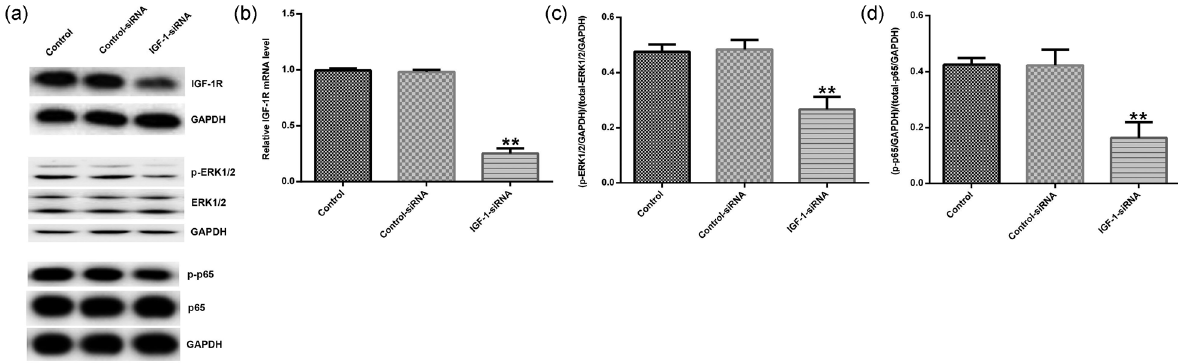
Figure 4: The e ff ect of IGF - 1 on MAKP and NF - κ B signaling pathways in HVFs from POP patients. Control siRNA and IGF - 1 siRNA were transfected into HVFs and then Western blotting assay was used to detect the protein levels of IGF - 1R, p - ERK1/2, ERK1/2, p - p65 and p65; and qRT - PCR was used to measure the mRNA level of IGF - 1R. ( a ) The e ff ect of IGF - 1 siRNA on IGF - 1R, p - ERK1/2, ERK1/2, p - p65, and p65 protein expression in HVFs. ( b ) The e ff ect of IGF - 1 siRNA on IGF - 1R mRNA expression in HVFs. ( c and d ) The e ff ect of IGF - 1 siRNA on p - ERK1/